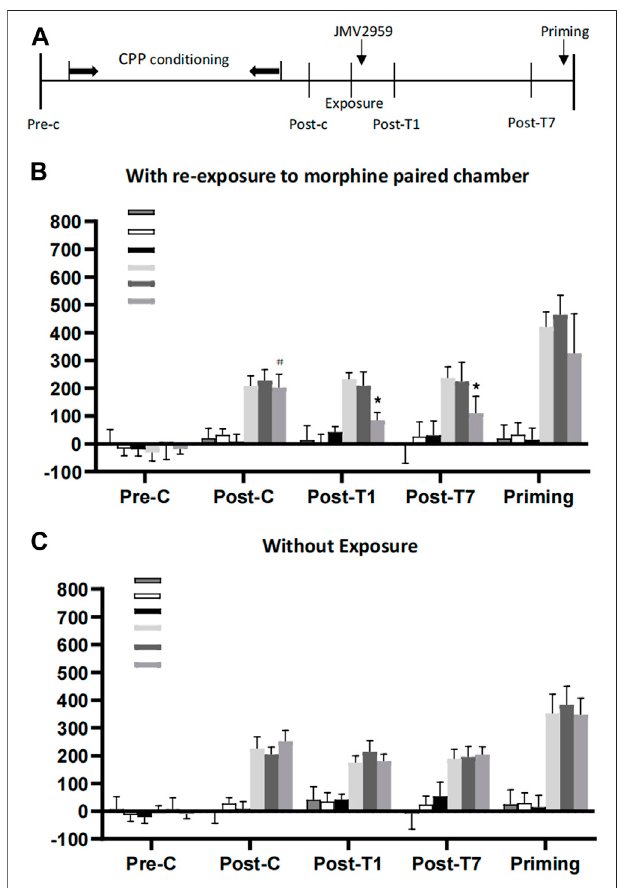
FIGURE1| TheeffectofJMV2959forratsonmorphinereconsolidation. (A) Timeline of the Experimental procedure (B) Systematic administration of JMV2959 immediately after exposure to morphine-paired context impaired the reconsolidation of morphine reward memory. The inhibitory effect of JMV2959 on the expression of morphine CPP last for 7d. When given 3 mg/kg morphine priming injection, rats in the group with 6 mg/kg JMV2959 treatment immediately after exposure reinstated the morphine CPP ( n (cid:1) 6-8 per group). * p < 0.01 vs . preconditioning or post-conditioning within group. # p < 0.01 vs . preconditioning or post-treatment within group. (C) Systemic administration of JMV2959 without exposure to morphine reward memory. Pre-C, preconditioning; Post-C, post-conditioning; Post-T1, post-treatment; Post-T14, post-treatment 14; Priming, injected by 3 mg/kg